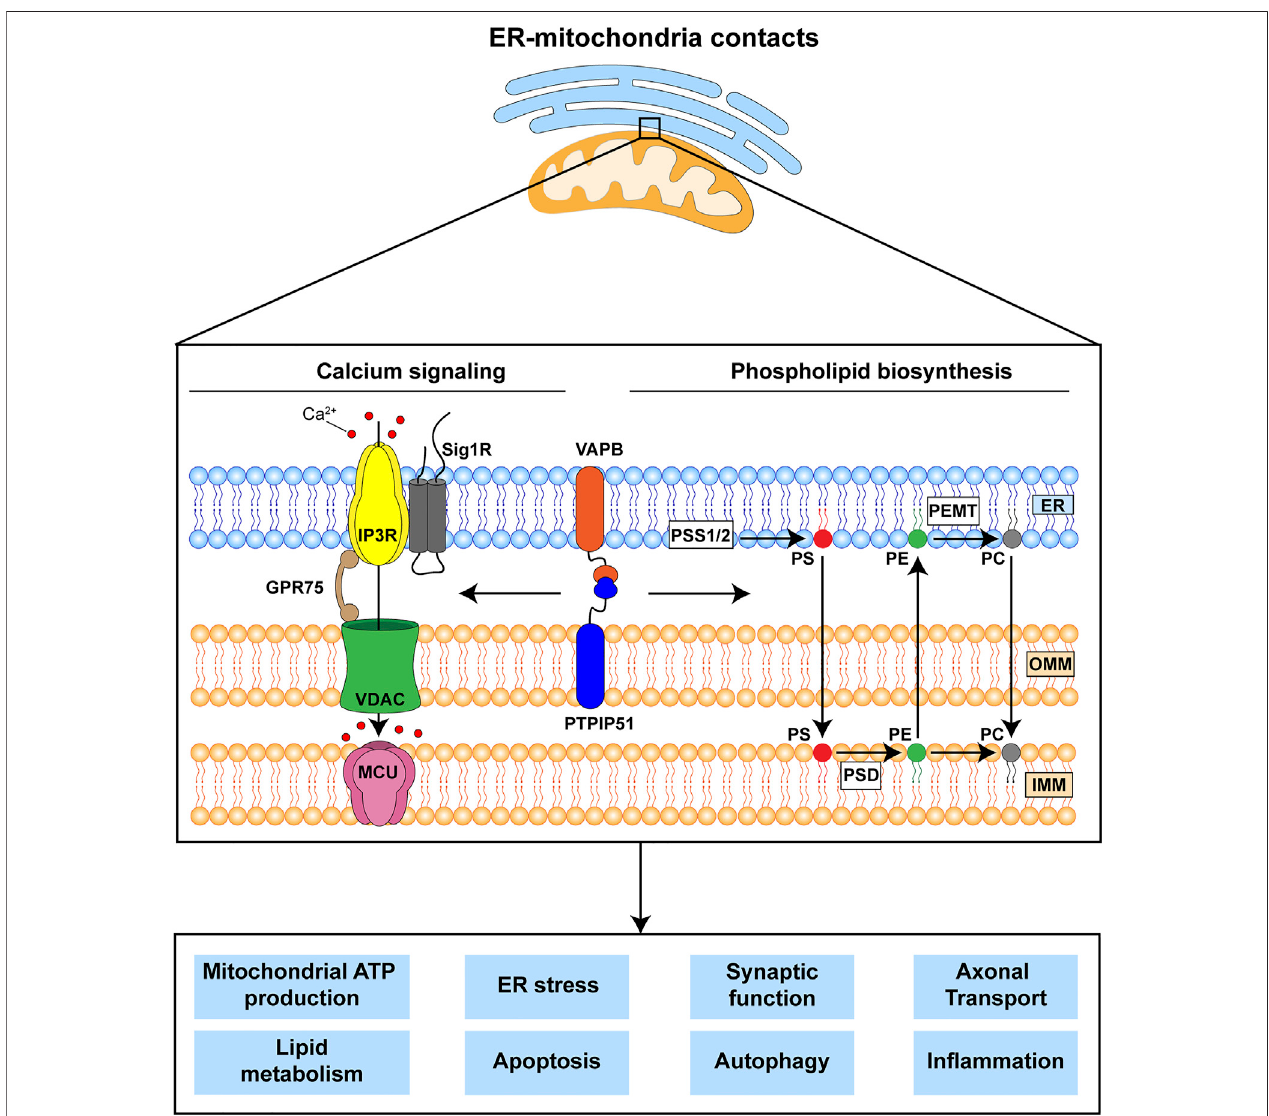
FIGURE1| TheVAPB-PTPIP51tethersregulatedeliveryofCa 2+ fromERstorestomitochondriaandphospholipidsynthesis.Theseprimaryfunctionsarebelieved toimpactuponanumberofotherdownstreamphysiologicalprocessesmanyofwhicharedamagedinFTD/ALS.TheVAPB-PTPIP51interactionfacilitatesCa 2+ transfer from ER to mitochondria via IP3R-GRP75-VDAC1. Phospholipid synthesis involves initial production of phosphatidylserine (PS) in MAM by PS synthase 1 and 2 (PSS1/ 2); this is transferred to mitochondria where PS decarboxylase (PSD) converts it to phosphatidylethanolamine (PE). PE can be transferred back to the ER, where phosphatidylethanolamine N-methyltransferase (PEMT) converts it to phosphatidylcholine (PC). Finally, PC can be also transferred back to mitochondria. ER, endoplasmic reticulum; IMM, inner mitochondrial membrane; IP3R, inositol 1,4,5-trisphosphate receptor; GPR75, glucose-regulated protein 75; MCU, mitochondrial Ca 2+ uniporter; OMM, outer mitochondrial membrane; Sig1R, Sigma-1 receptor; VDAC1, voltage-dependent anion-selective channel.